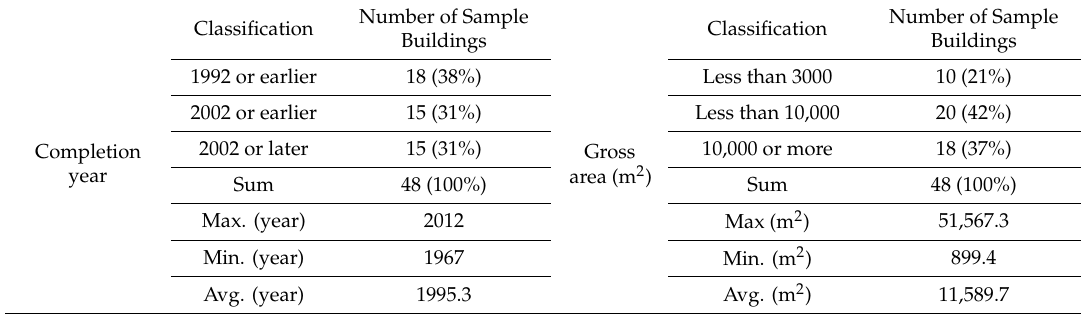
Table 5. Distribution of the sample o ffi ce buildings.